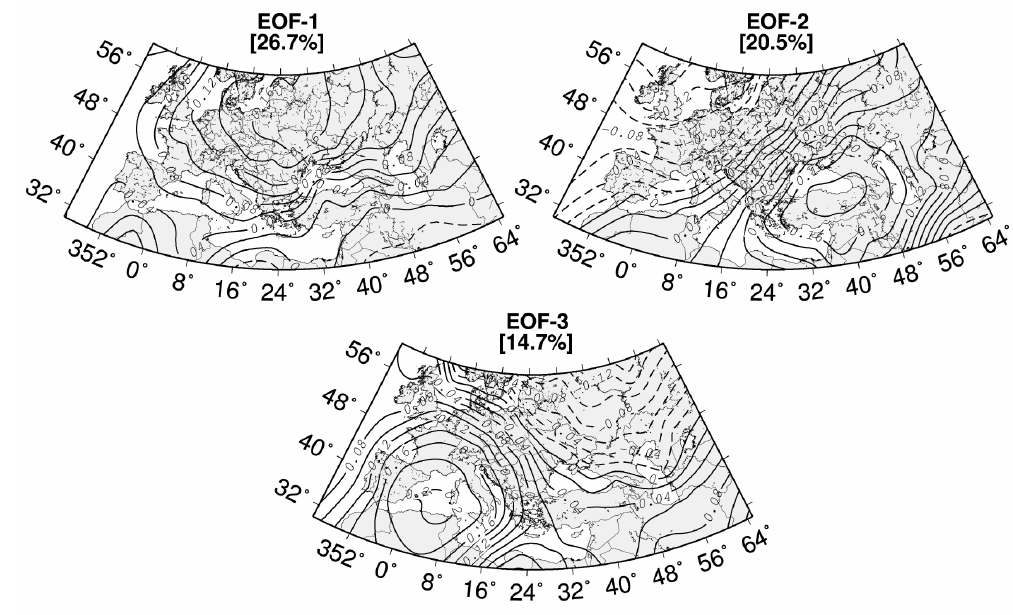
Fig. 5. The three obtained EOF and their explained variance, for all cases.